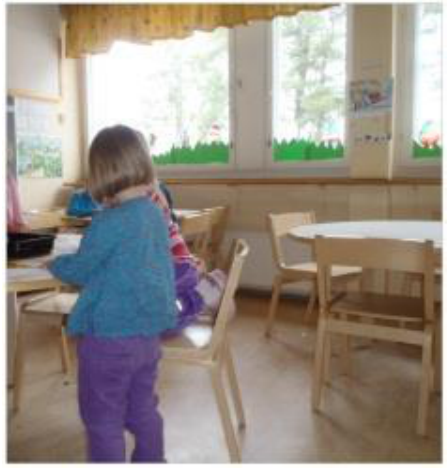
Figure 6. I have an influence on what I